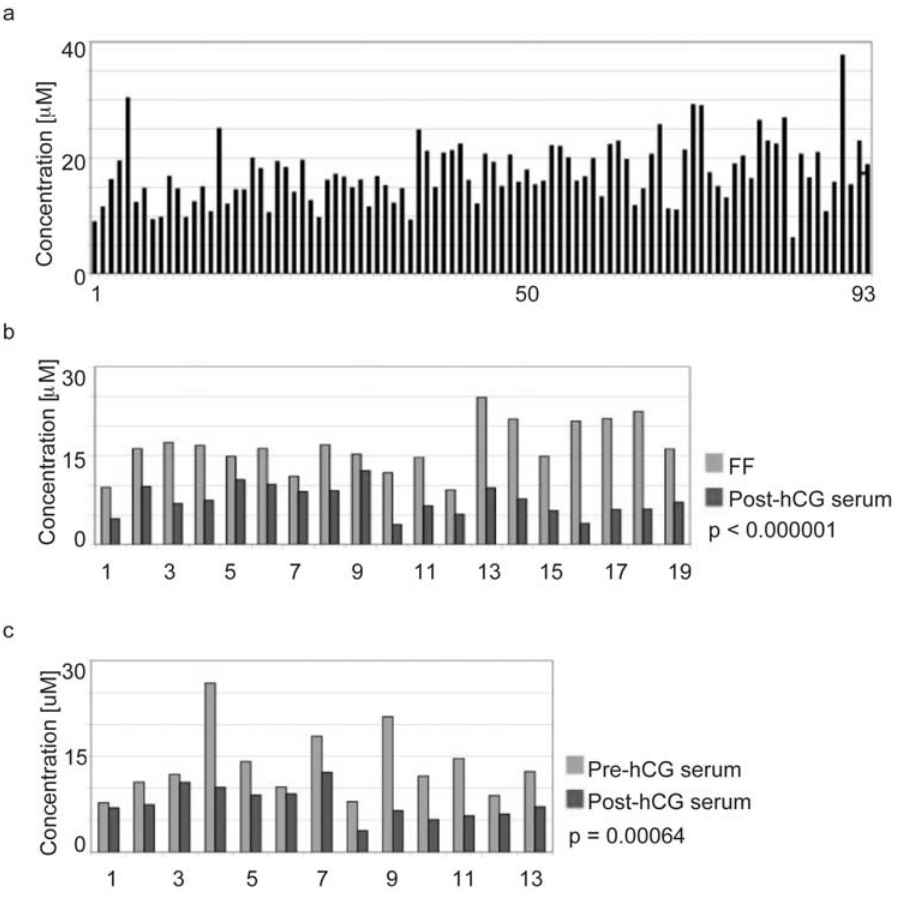
Figure 1. Presence of bile acids in human ovarian follicular fluid. Bile acid concentration was measured in FF (Panel a), in FF compared to post-HCG serum (Panel b), and in pre-HCG serum compared to post-HCG serum (Panel c).